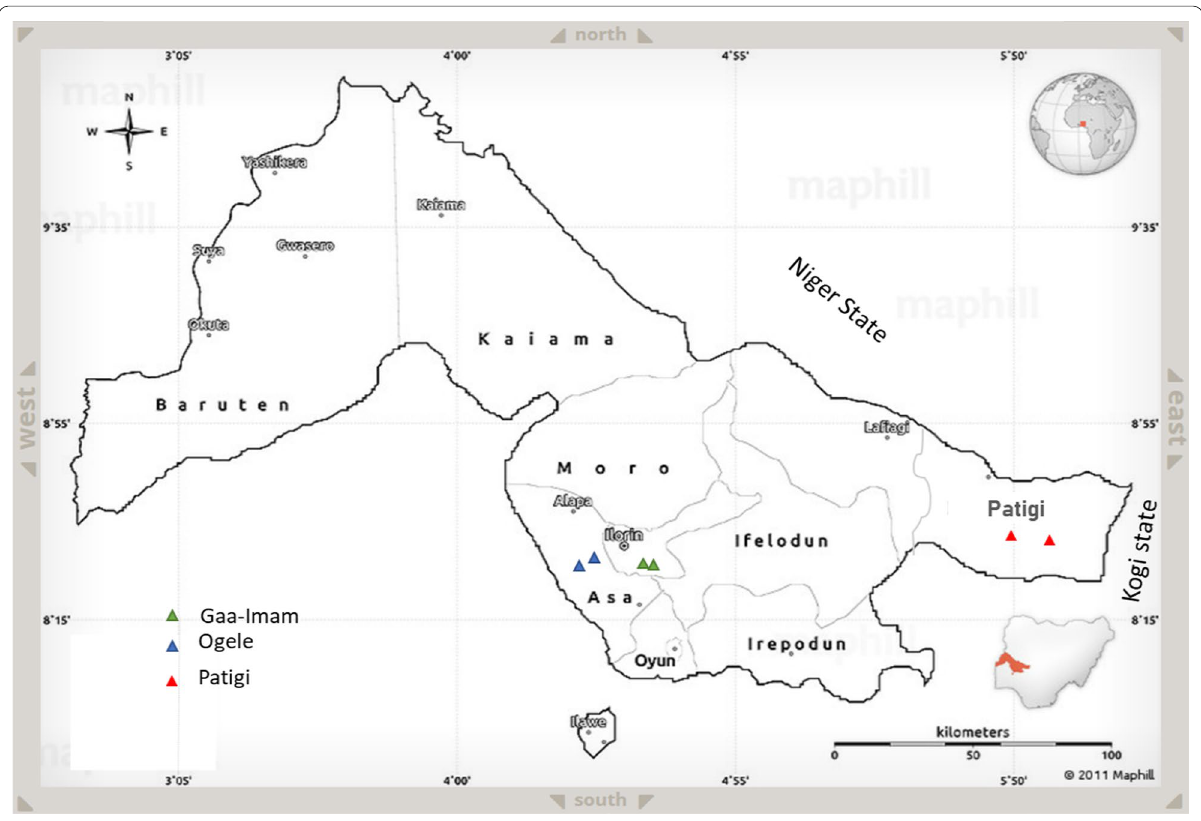
Fig. 1 Global map showing our study locations in Kwara state,